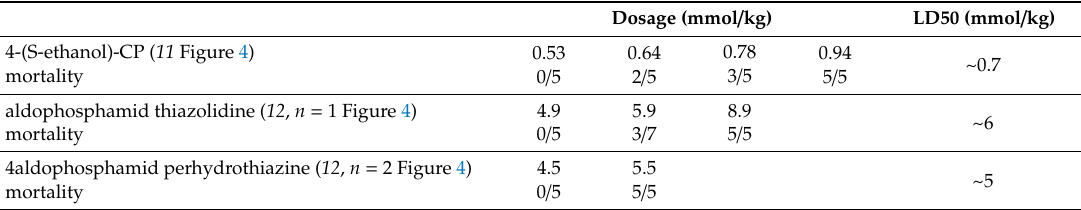
Figure 4. Hydrolysis of 4-(S-ethanol)-cyclophosphamide ( 11 ) via OHCP and direct hydrolysis of aldophosphamide thiazolidine ( 12 n = 1) and aldophosphamide perhydrothiazine ( 12 n = 2) to aldophosphamide ( 3 ) and enzymatic cleavage of aldophosphamide to phosphoreamidemustard ( 4 ) and hydroxypropanal ( 5 ).